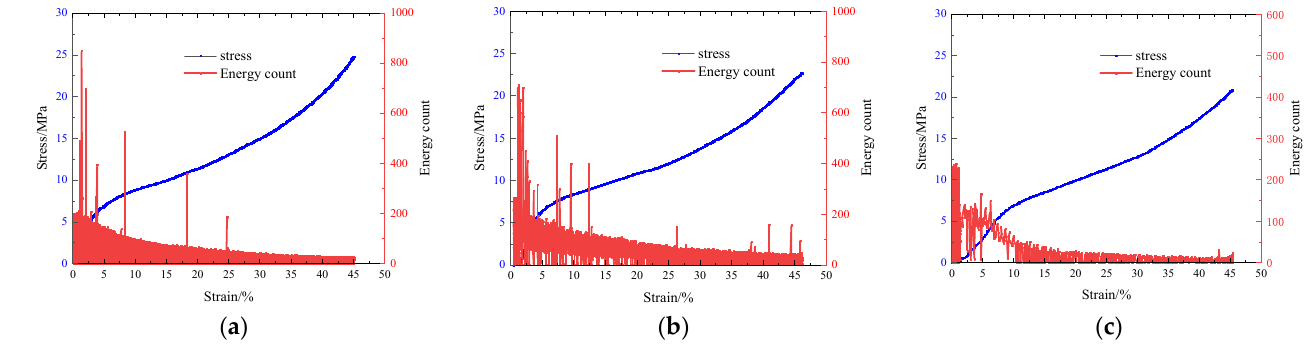
Figure 8. Engineering stress–strain curves and AE energy count relationships at various compression rates: ( a ) 2 mm/min; ( b ) 10 mm/min; ( c ) 50 mm/min.